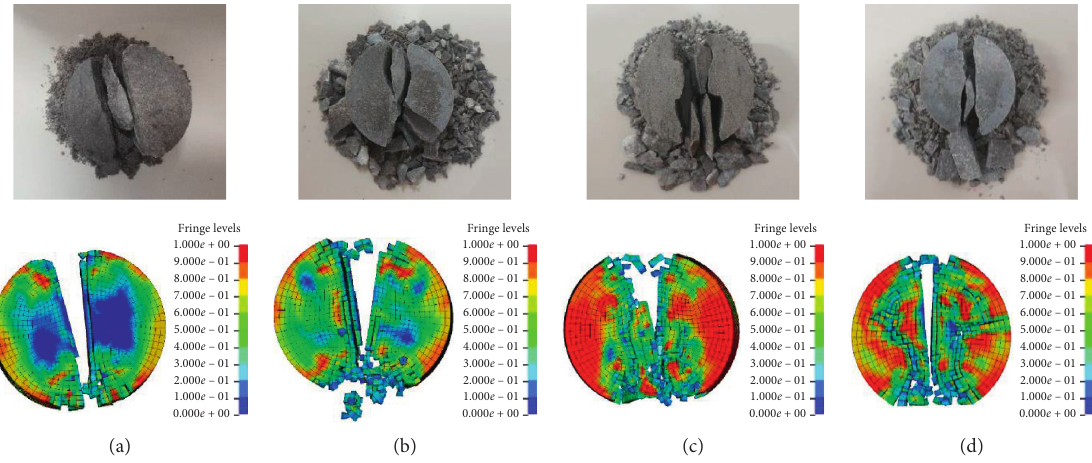
Figure 8: Rock failure under impact split. (a) _ ε � 143 . 0 (b) _ ε � 262 . 1 (c) _ ε � 303 . 7 (d) _ ε � 340 .